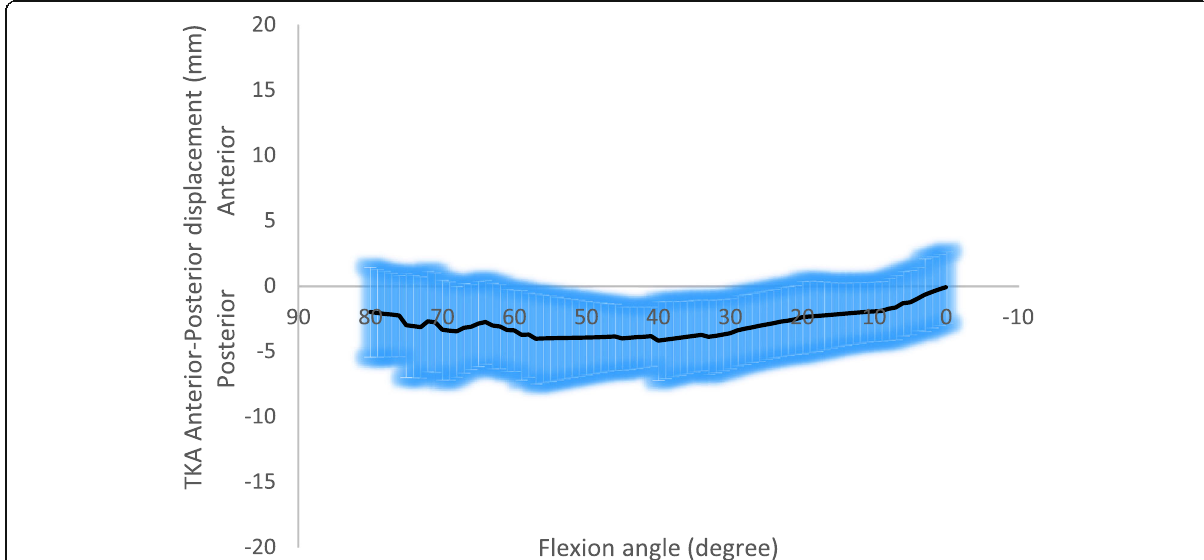
Fig. 3 Total knee arthroplasty Anterior-Posterior translation (mean and standard